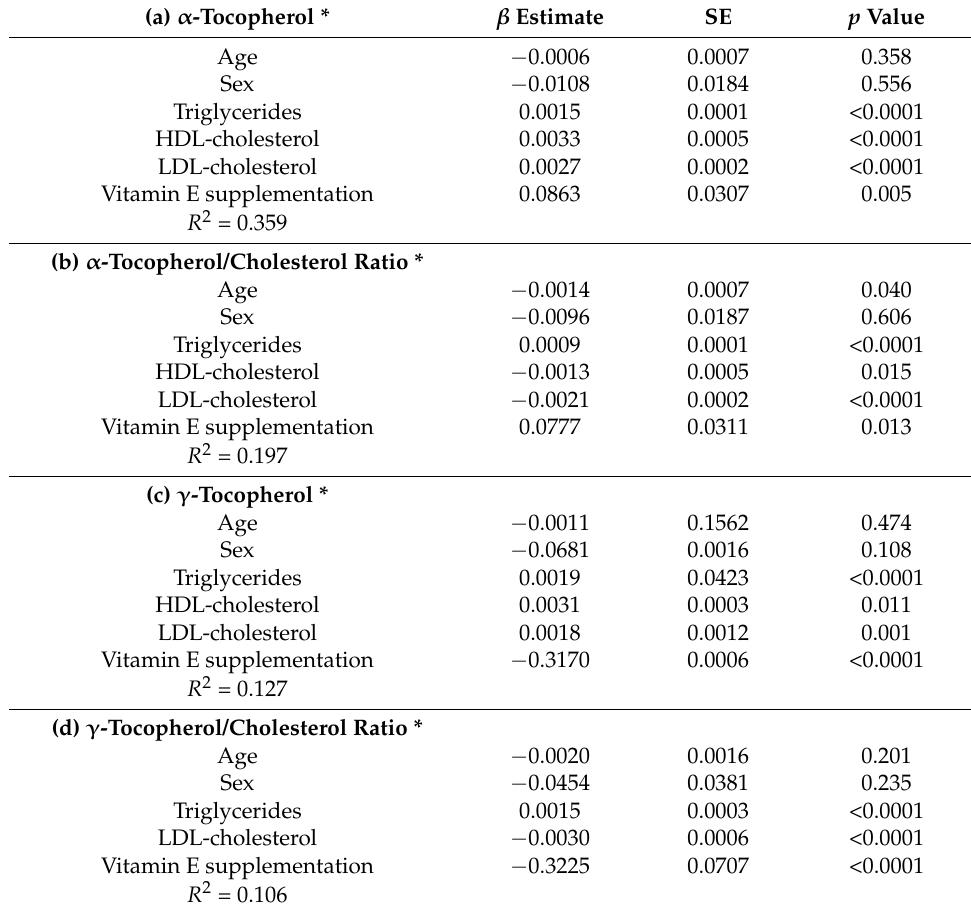
Table 2. Correlates for (a) α -tocopherol (b) α -tocopherol/cholesterol ratio, (c) γ -tocopherol, and (d) γ -tocopherol/cholesterol ratio.